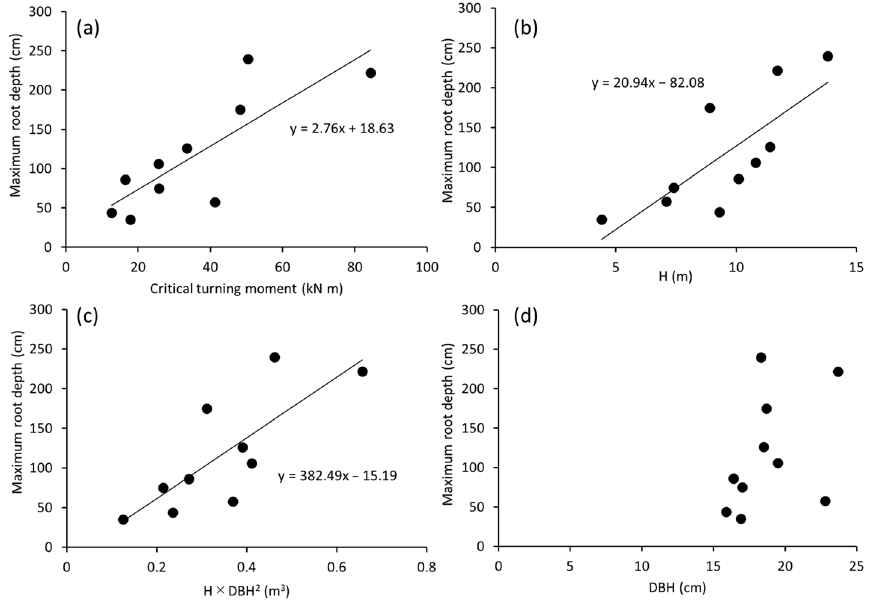
Figure 5. Relationships between ( a ) maximum root depth and critical turning moment, ( b ) maximum root depth and H, ( c ) maximum root depth and H × DBH 2 , and ( d ) maximum root depth and DBH.